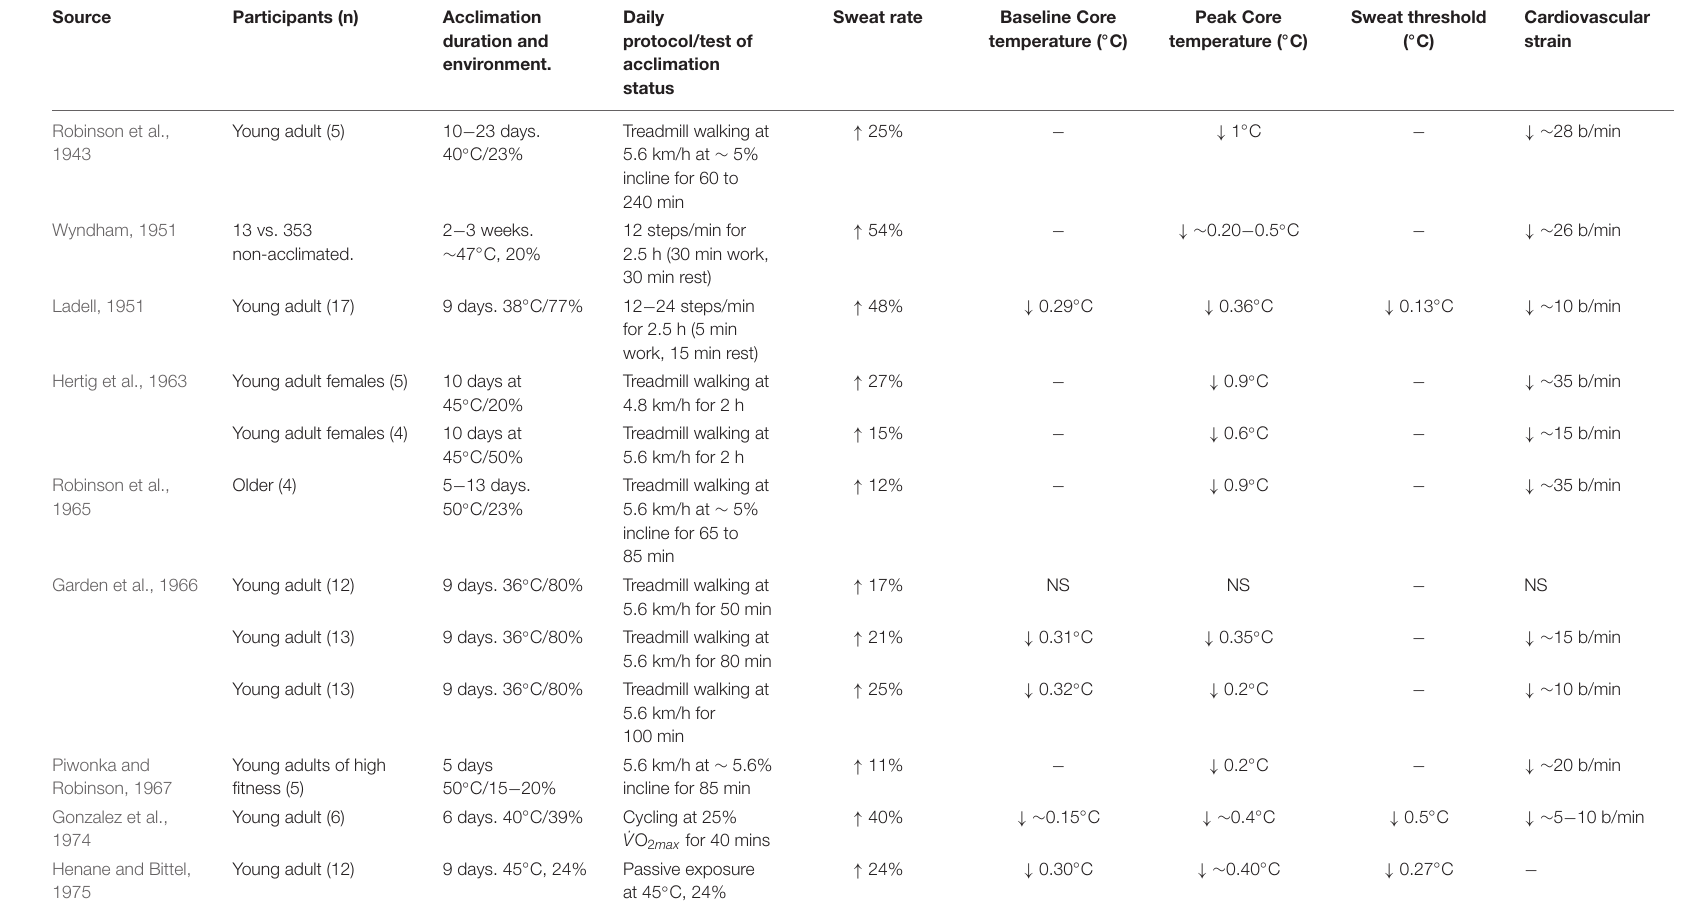
TABLE 6 | Overview of data relating to the effect of acclimation on the heat stress response. Participants are young adult males, unless stated